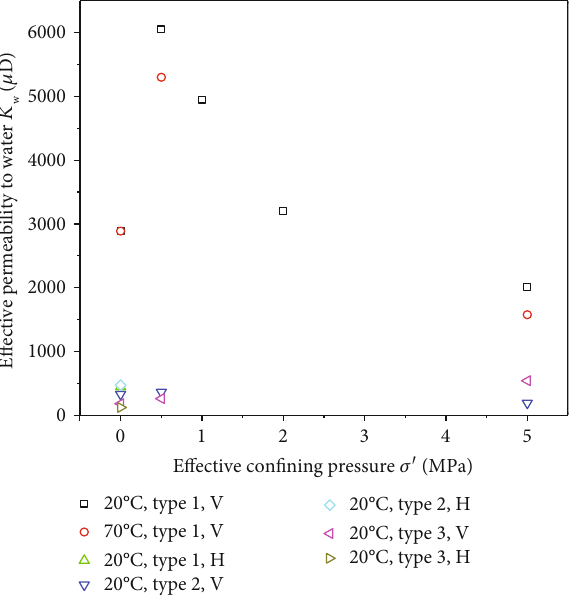
Figure 3: Permeability of Karamay oil sands before ( σ ′ = 0 ) and after ( σ ′ > 0 ) triaxial compression tests under varying con fi ning